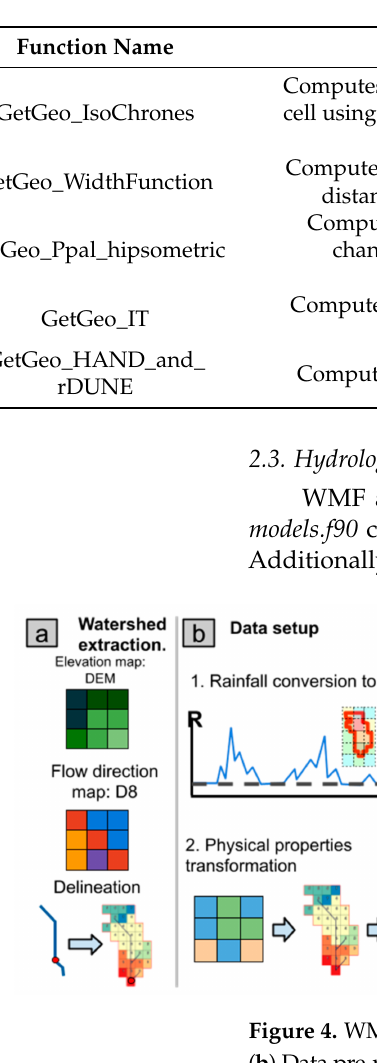
Table 3. Basin class advanced geomorphological analysis function collection.